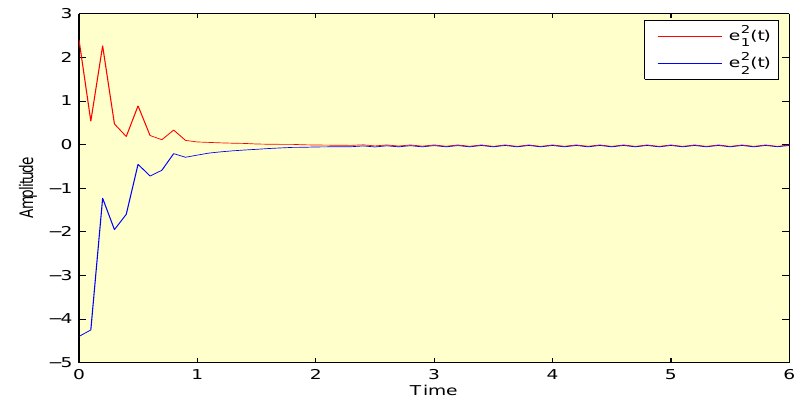
( t ) , (cid:101) 2 ( t ) of NN model (11) under con- 2 1